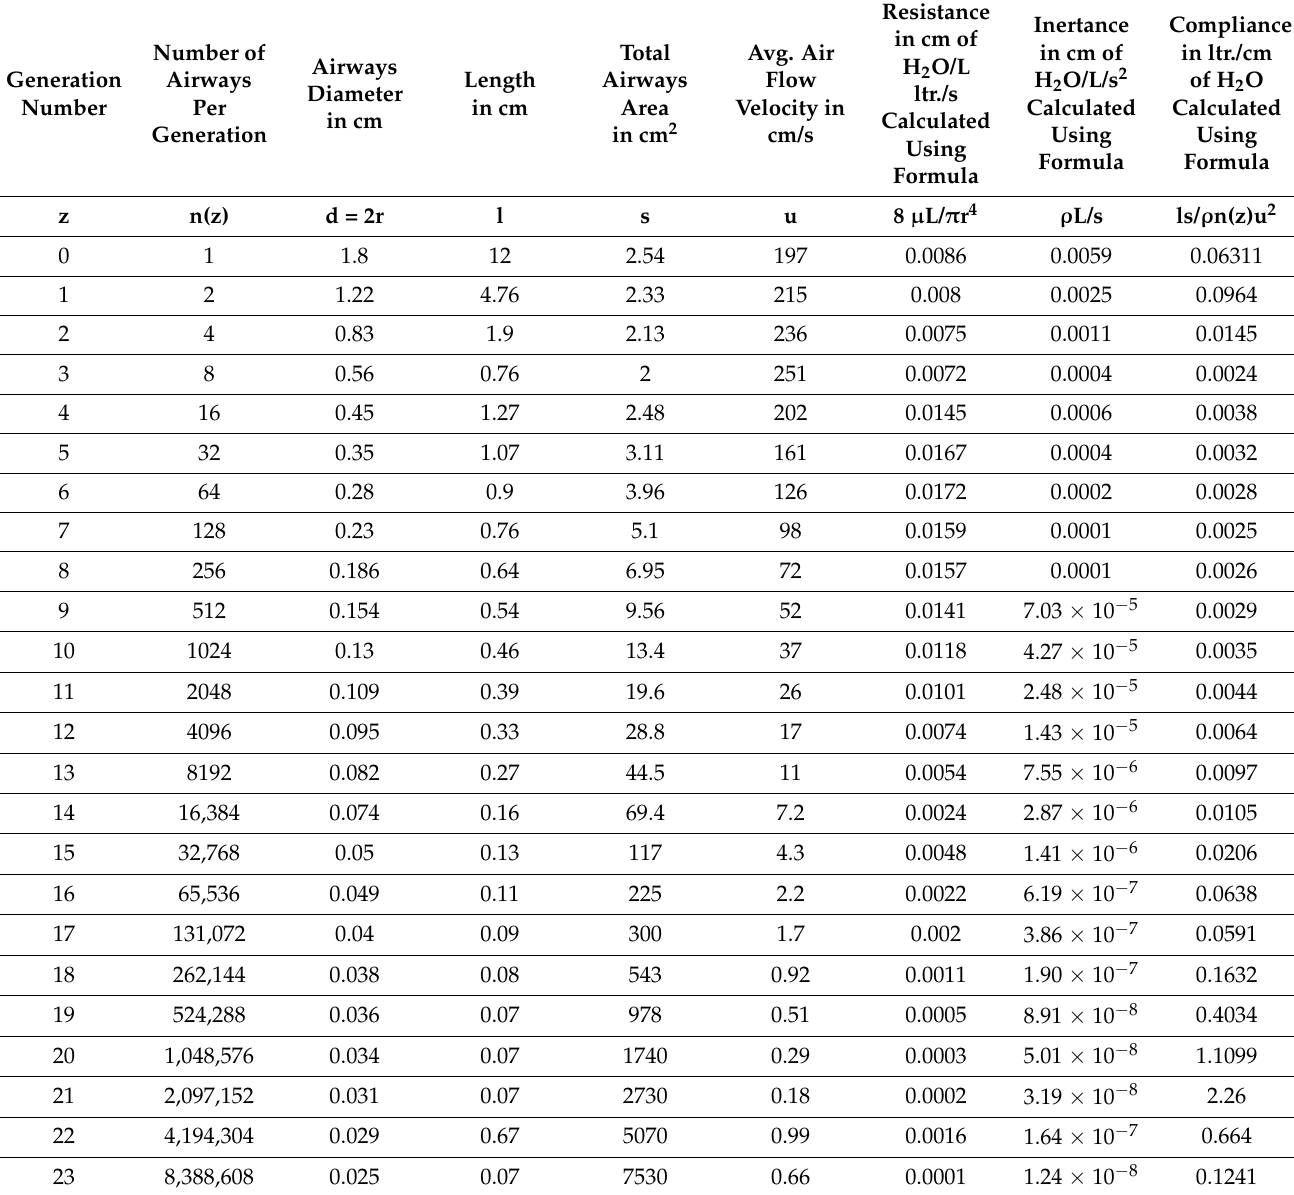
Table 1. Geometrical dimensions of the morphological model of the respiratory system.